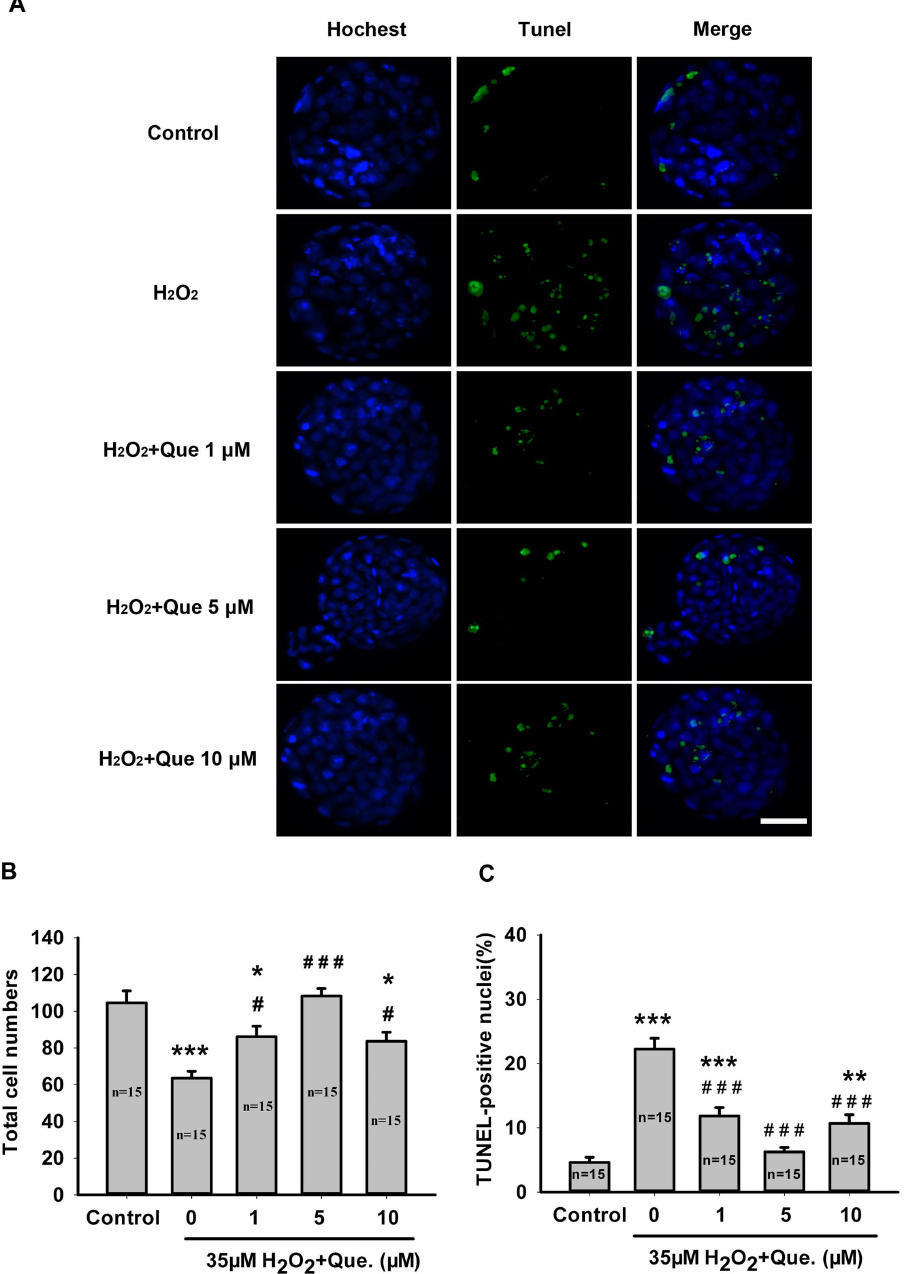
Figure 2. Quercetin attenuated H 2 O 2 -induced apoptosis in blastocysts. (A) Representative images of TUNEL positive cells in mouse blastocysts after treatment with H 2 O 2 or H 2 O 2 plus Que during the zygote stage. TUNEL positive cells were stained with Alexa Fluor 488 dye and all nuclei were labeled with Hoechst 33342 (blue). Bar, 50 m m. (B) Quantification of the total cell numbers per blastocyst. (C) Percentage of TUNEL positive cells per blastocyst. Data are presented as mean 6 SEM from three independent experiments. N shows the number of blastocysts. * P , 0.05, ** P , 0.01, *** P , 0.001 vs. the control group; # P , 0.05, ## P , 0.01, ### P , 0.001 vs. the H 2 O 2 -treated group (One-way ANOVA).